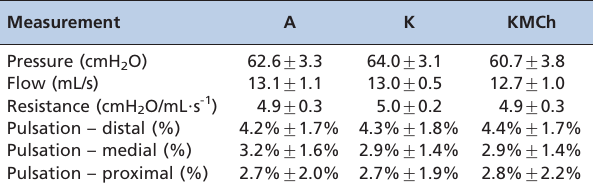
Table 2 - DECEL group measurements.